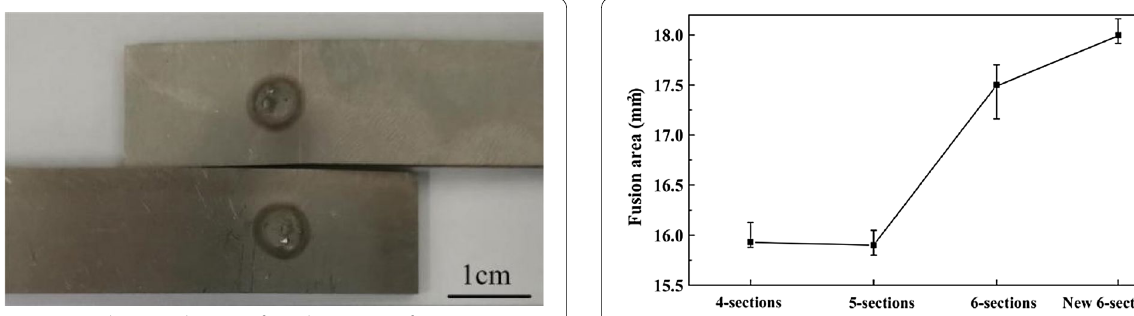
Figure 23 Schematic diagram of tensile specimen fracture